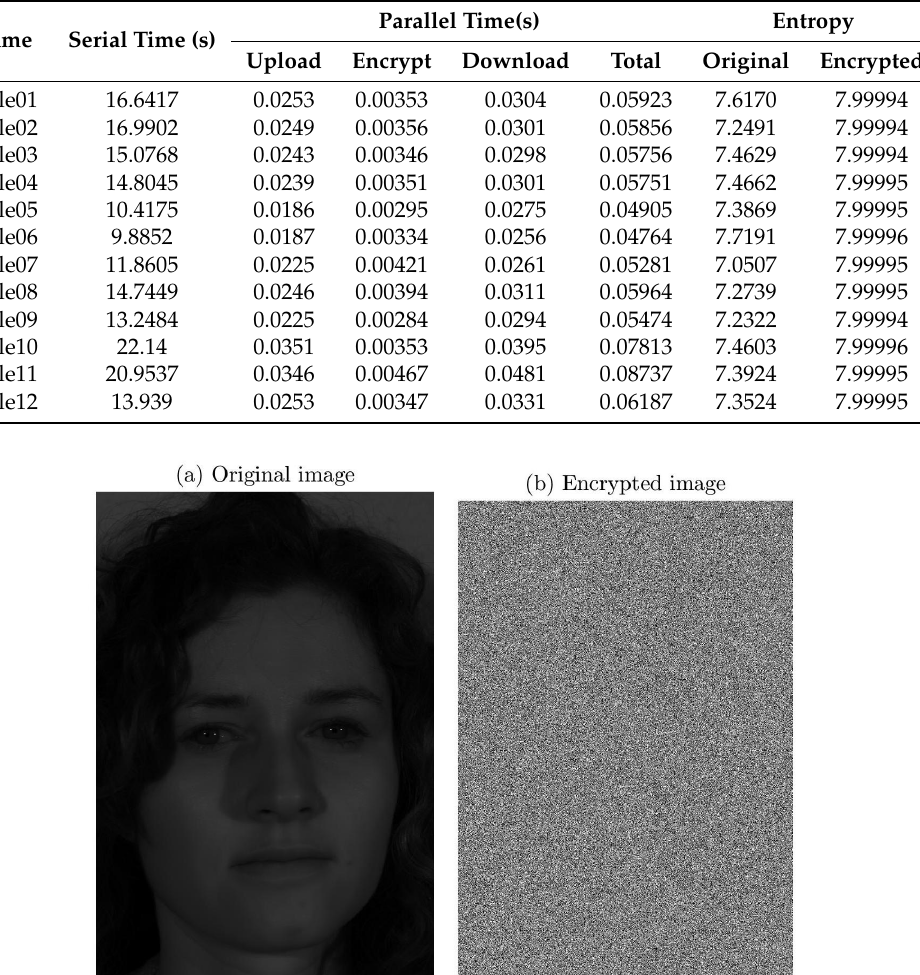
Table 3. Male data set encryption results.